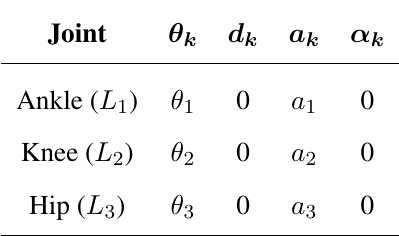
Table 1. Denavit–Hartenberg parameters of the leg